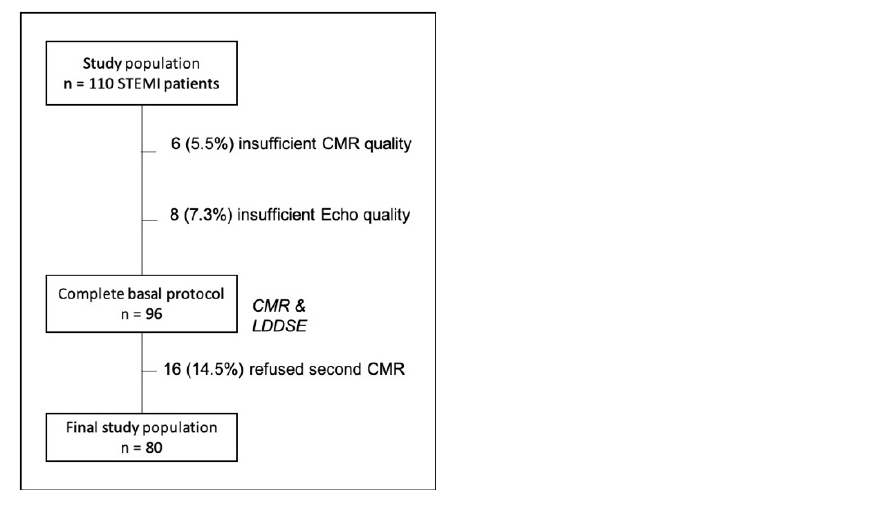
Figure 1. Flow chart showing the study population and reasons for patient exclusion. Table 1. Baseline characteristics of the study population ( n = 80).